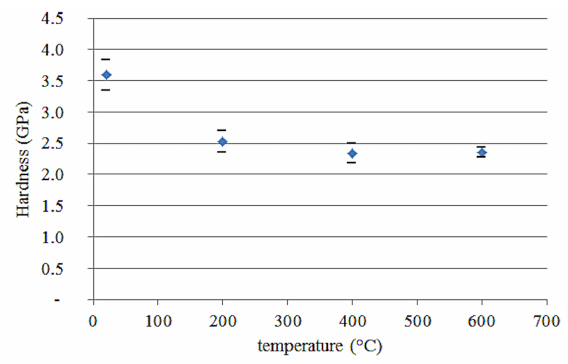
Figure 5. Variation of hardness on stainless steel up to 600 ◦ C